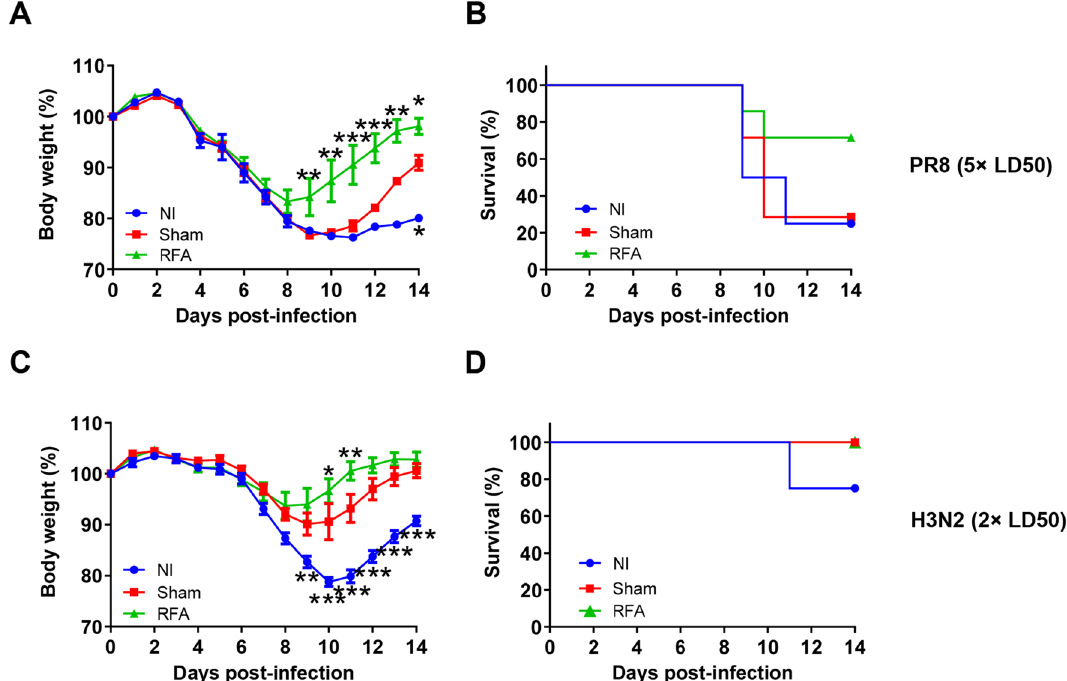
Figure 7. Induction of cross-protection by RFA. ( A , B ) BALB/c mice were challenged with 5 × LD50 of PR8 viruses. Body weight ( A ) and survival ( B ) were monitored daily for 14 days. ( C , D ) BALB/c mice were challenged with 2 × LD50 of H3N2 viruses. Body weight change ( C ) and survival ( D ) were monitored daily for 14 days. n = 4 for NI; n = 7 for sham and RFA. Two-way ANOVA with Tukey’s post-test was used to compare body weight differences between sham and other groups at different time points in ( A ) and ( C ). *p < 0.05; **p < 0.01; ***p <